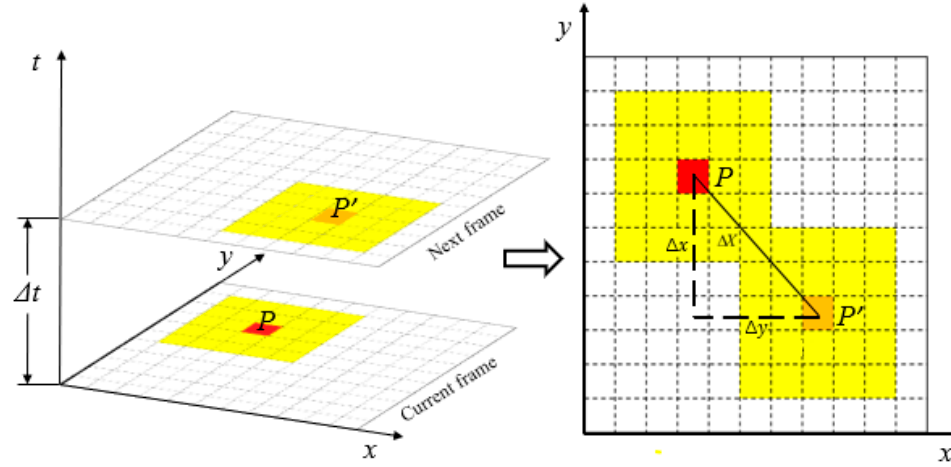
Figure 1. The schematic diagram of a target point tracking.